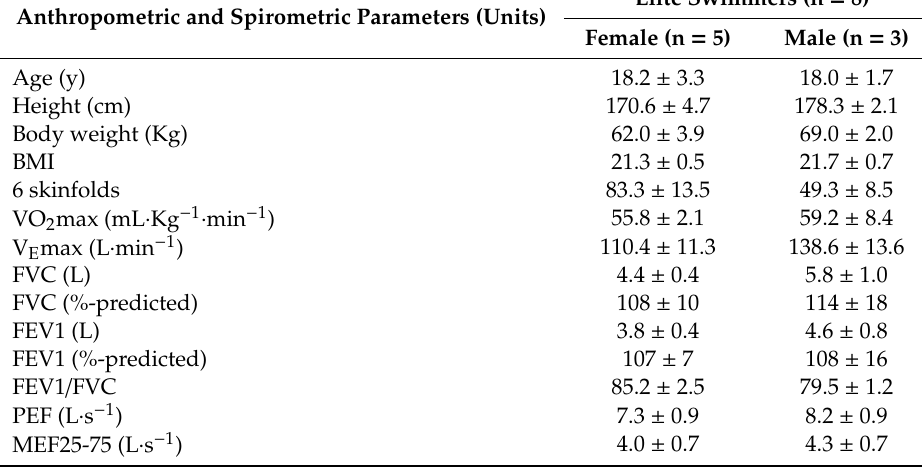
Table 1. Anthropometrical and physical capacity parameters of the studied sample of elite swimmers. Anthropometric and Spirometric Parameters